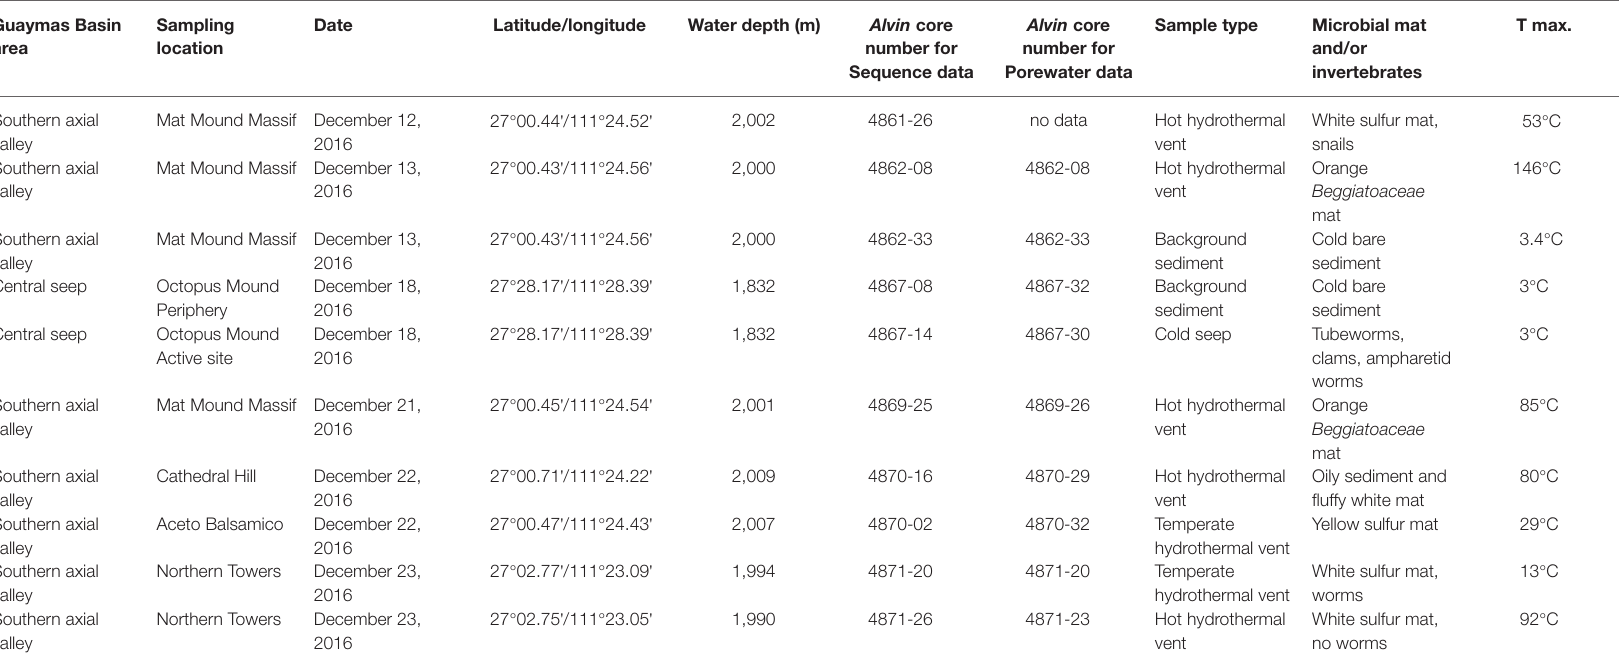
TABLE 1 | Sampling sites and Alvin core numbers for 2016 sediment samples collected during Atlantis cruise AT37-06, used in parallel molecular and biogeochemical analyses.